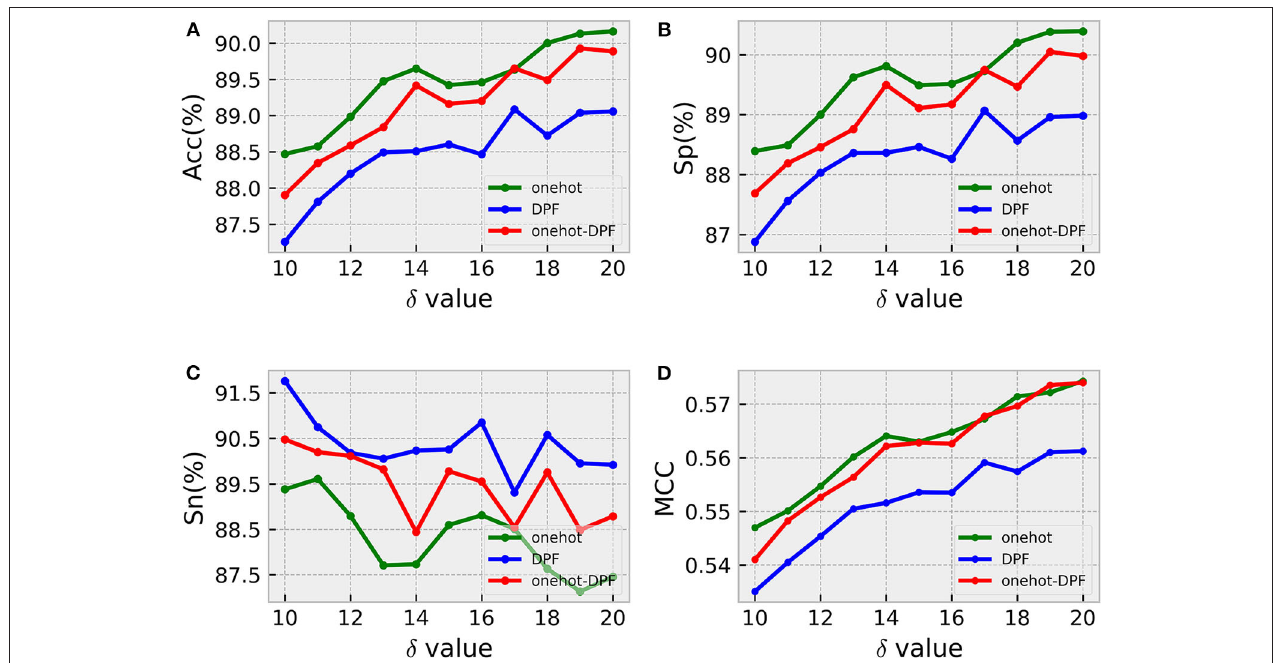
FIGURE 3 | Windows size analysis. Sub-graphs from (A–D) represent the ACC, Sp, Sn, MCC values generated by three different feature coding methods under different sliding window sizes, respectively.